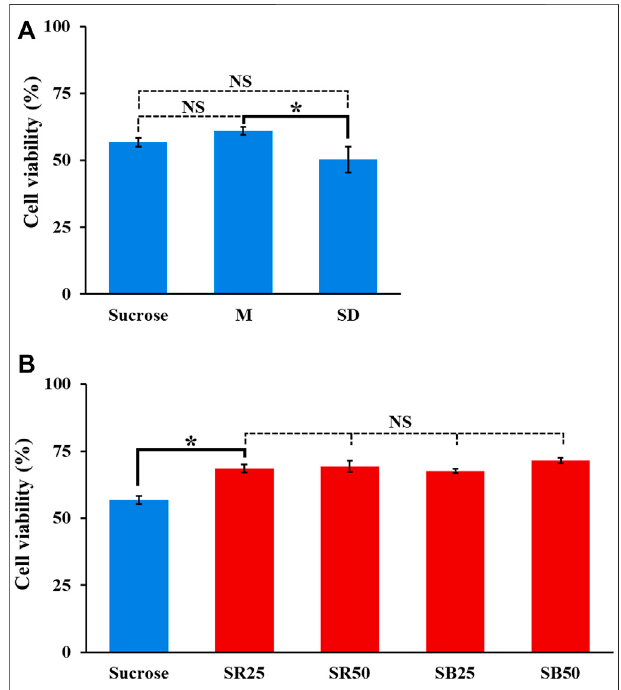
FIGURE 5 | The cell viability (%) of PC-3 cancer cells incubated in the prepared background solutions with (A) lower and (B) higher conductivity for 4 h (M, SD, SR25, SR50, SB25, and SB50 are the background solutions prepared according to Table 1 ). The results are presented as the mean ± standard deviation of at least 3 separate experiments. [NS, no signi fi cance and *, signi fi cant difference ( p <